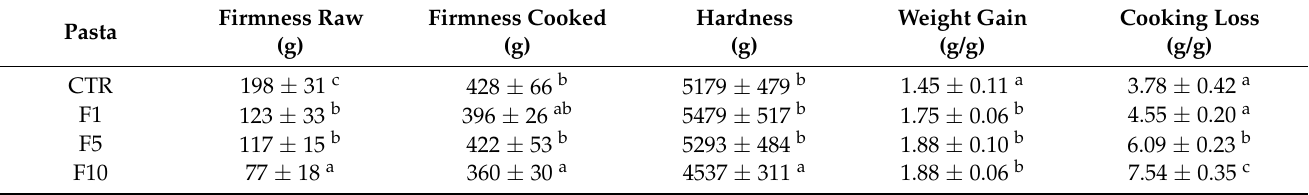
Table 2. Texture and cooking properties of semolina pasta (CTRL) and pasta enriched with F. vesiculosus (F1, F5,